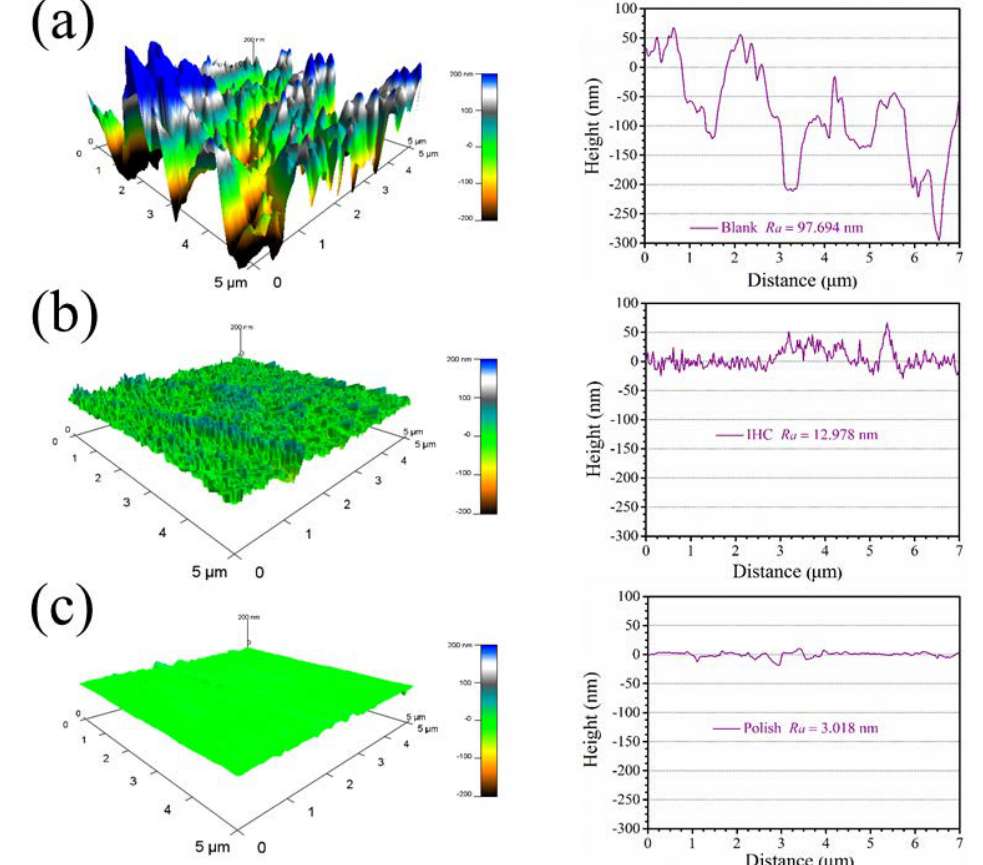
Figure 8. 3D topography of copper under different conditions; ( a ) copper sample soaked in 0.5 mol/L H 2 SO 4 for 24 h without itraconazole and the 2D topography image on the diagonal. ( b ) The copper sample was soaked in 0.5 M sulfuric acid for 24 h containing 5 mM itraconazole and the 2D topography image on the diagonal, and ( c ) the freshly polished copper surface and the 2D topography image on the diagonal.